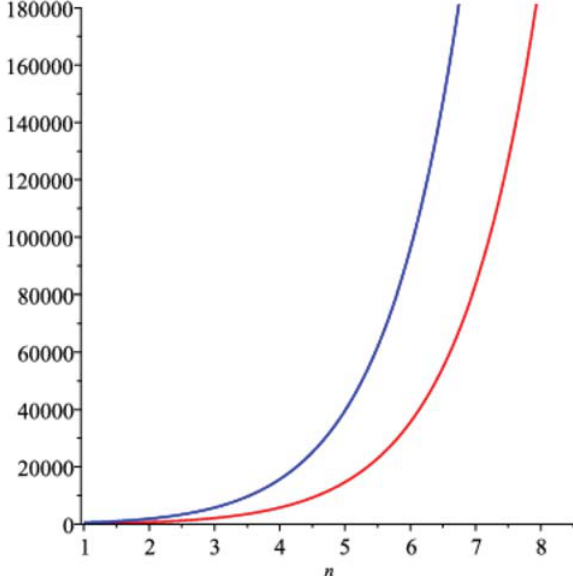
Figure 4: Comparison of the total-eccentricity index of ς ( SD [r]) and PD [r]. The colors green and blue represents the total-eccentricity index of ς ( SD [r]) and PD [r], respectively. We can see that in the given domain the total-eccentricity index of ξ ( SD [r]) is more